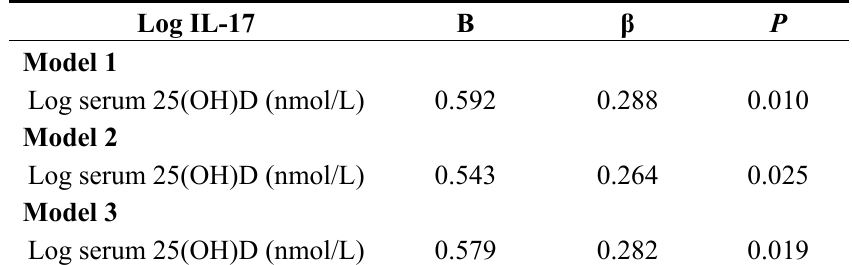
Table 2. Results from multiple linear regression analyses examining the association between serum 25(OH)D and plasma